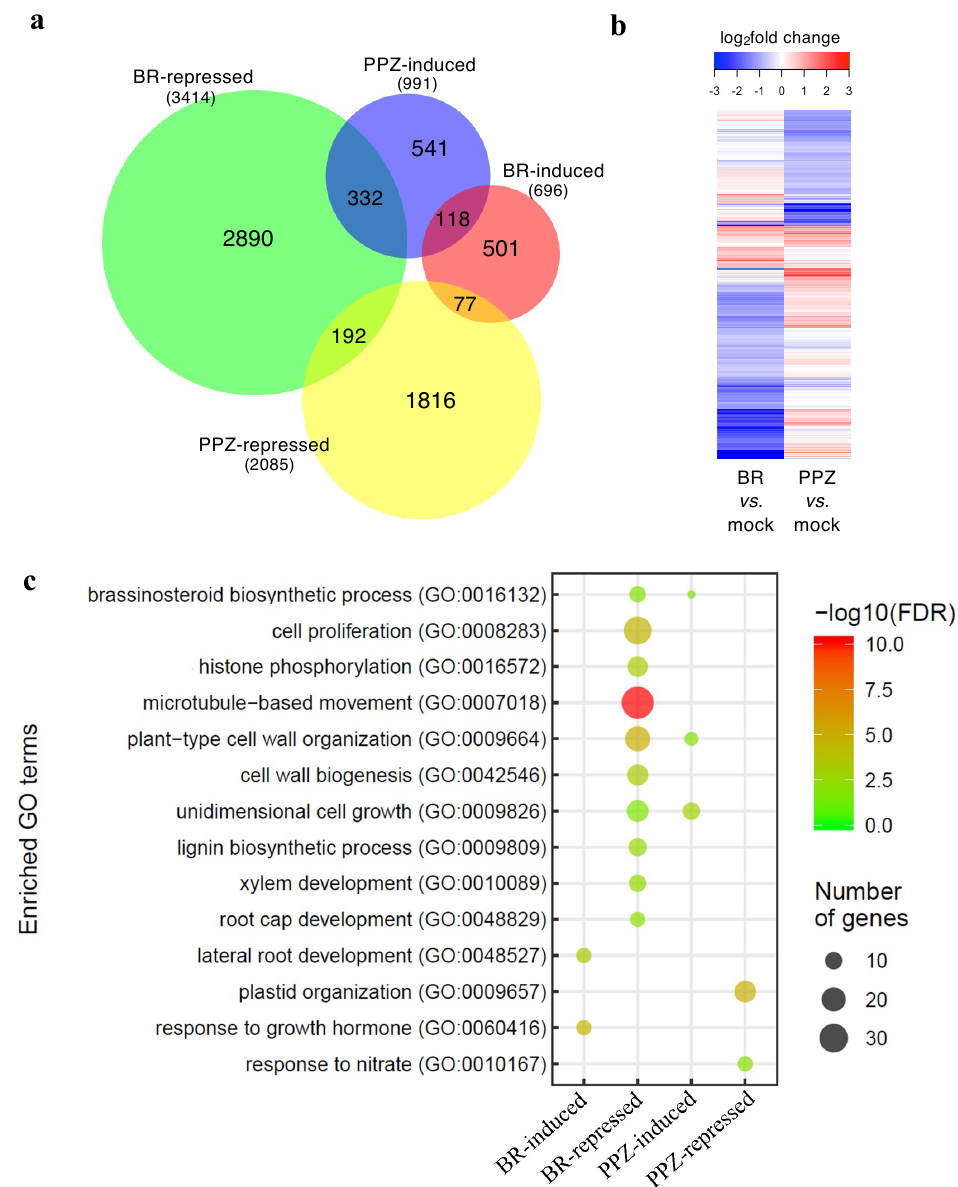
Figure 3. Transcriptomic analysis of differentially expressed genes in ECS- and PPZ-treated rice roots. ( a ) Venn diagram showing the overlap between the lists of significant ECS-induced, ECS-repressed, PPZ-induced and PPZ-repressed genes (|fold change| > 1.5; adjusted p -value < 0.05). The numbers of DEGs are shown in parentheses. ( b ) Hierarchically clustered heatmap displaying the log 2 FC values of all significant genes in the ECS vs. mock or PPZ vs. mock comparisons. ( c ) GO biological process term enrichment analysis of the ECS and PPZ DEG